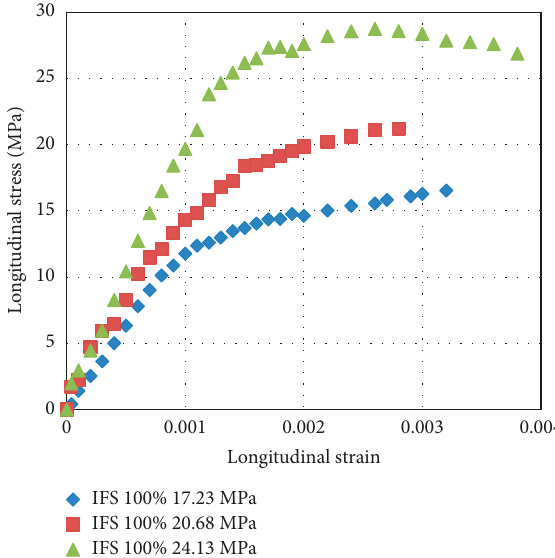
Figure 22: Longitudinal stress-strain diagram 100% IFS concrete.